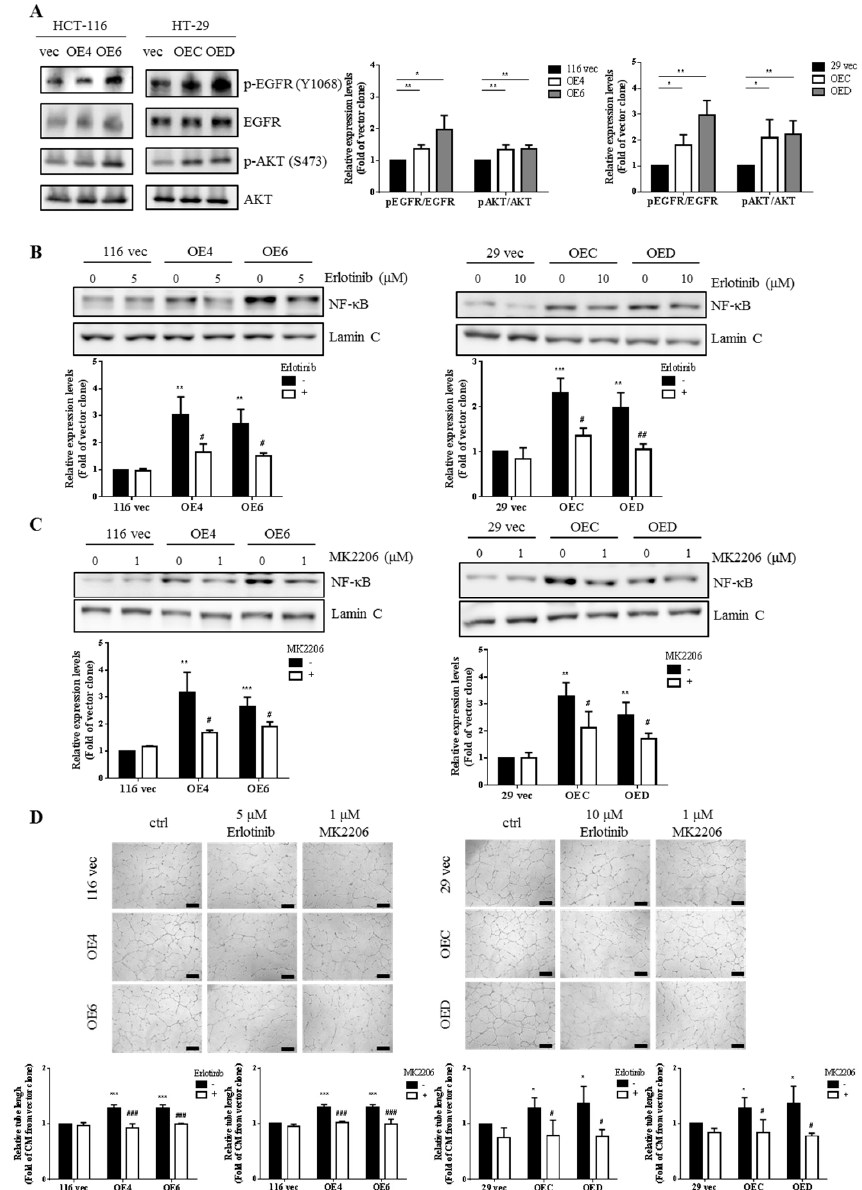
Figure 5. The EGFR/AKT pathway is responsible for the activation of NF- κ B in the GATA6-overexpressing human CRC clones. ( A ) Total lysates (20 μ g) prepared from three clones derived respectively from HCT-116 and HT-29 cells were subjected to western blot analyses using primary antibodies phospho-EGFR (Y1068), total EGFR, phospho-AKT (S473), and total AKT as probes, respectively. The quantitative results (bar graphs) obtained by densitometry are the mean ± SD of three independent experiments. * p < 0.05 and ** p < 0.01 compared with the respective vector clones by Student’s t -test. Nuclear fractions (20 μ g) prepared from the aforementioned clones after they were treated without or with 5 or 10 μ M erlotinib ( B ) and without or with 1 μ M MK2206 ( C ), respectively, for 24 h were subjected to western blotting to examine the nuclear levels of NF- κ B p65. Lamin C signal was used as a nuclear loading control. The quantitative results obtained by densitometry (the lower panels). The quantitative results (bar graphs) were obtained by densitometry. ( D ) Tube formation assays of HUVECs were carried out primarily as described above except that cells were treated respectively without or with 5 or 10 μ M erlotinib as well as without or with 1 μ M MK2206 before the CM being collected. The quantitative results in ( B – D ) (bar graphs) are the mean ± SD of three independent experiments. * p < 0.05, ** p < 0.01, and *** p < 0.005 compared with the respective untreated vector clones by Student’s t -test. # p < 0.05, ## p < 0.01, and ### p < 0.005 compared with the corresponding untreated groups by Student’s t -test.